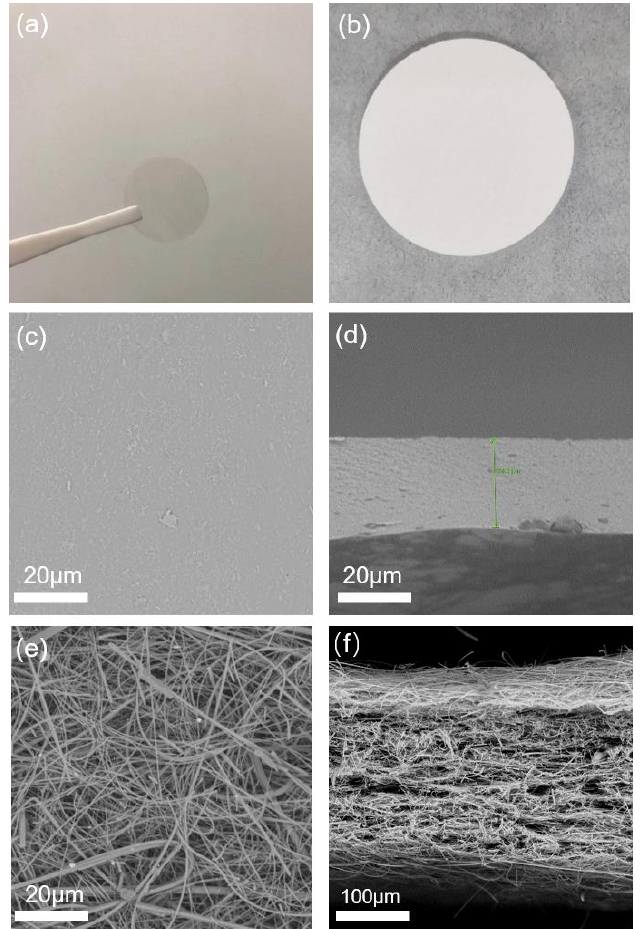
Figure 1. The photographs of ( a ) the prepared ZA membrane and ( b ) the glass-fiber separator. SEM images of ( c ) the surface of the ZA membrane, ( d ) the cross-section of the ZA membrane; ( e ) the surface of the glass-fiber separator, and ( f ) the cross-section of glass-fiber separator.